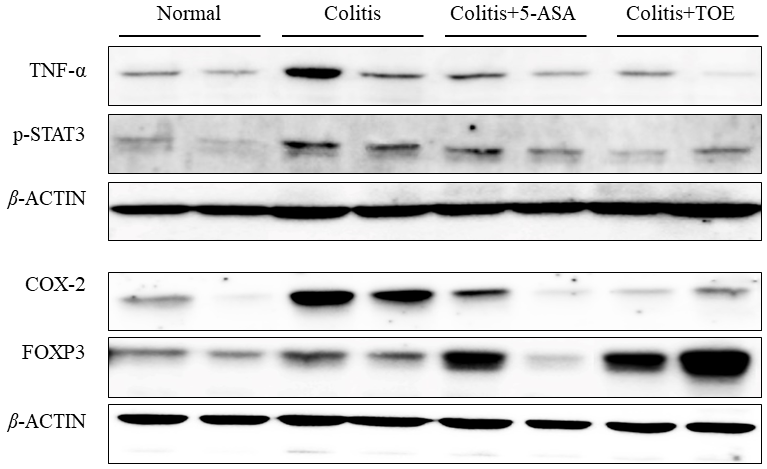
Figure 7. Effect of M2 fraction of Turbinaria ornata extract (TOE) on inflammatory markers and cytokines determined in chronic colitis tissues with western blotting. Six animal samples (colon lysates) per group were analyzed in duplicate. Normal, DSS ‐ /D.W; colitis, DSS + /D.W, colitis + 5 ‐ ASA, DSS + /5 ‐ ASA 50 mg per kg; colitis + TOE, DSS + /TOE 15 mg per kg.